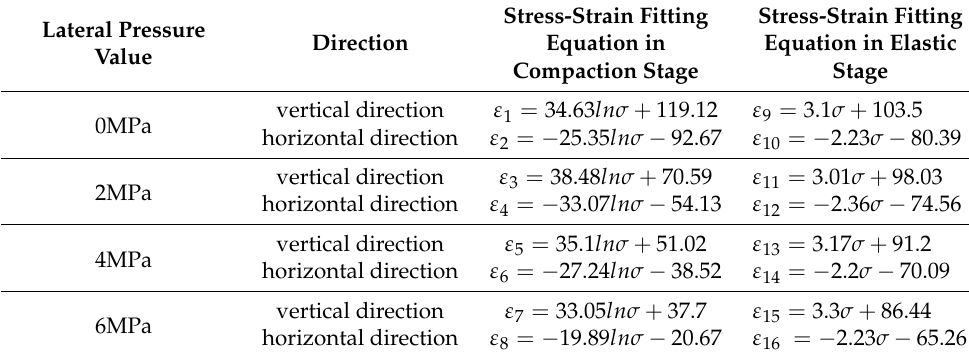
Table 4. Fitting equations of stress and strain in vertical and horizontal directions under different lateral pressures. Stress-Strain Fitting Stress-Strain Fitting Lateral Pressure Equation in Elastic Direction Equation in Value Stage Compaction Stage vertical direction ε 1 = 34.63 ln σ + 119.12 ε 9 = 3.1 σ + 103.5 0MPa horizontal direction ε 2 = − 25.35 ln σ −